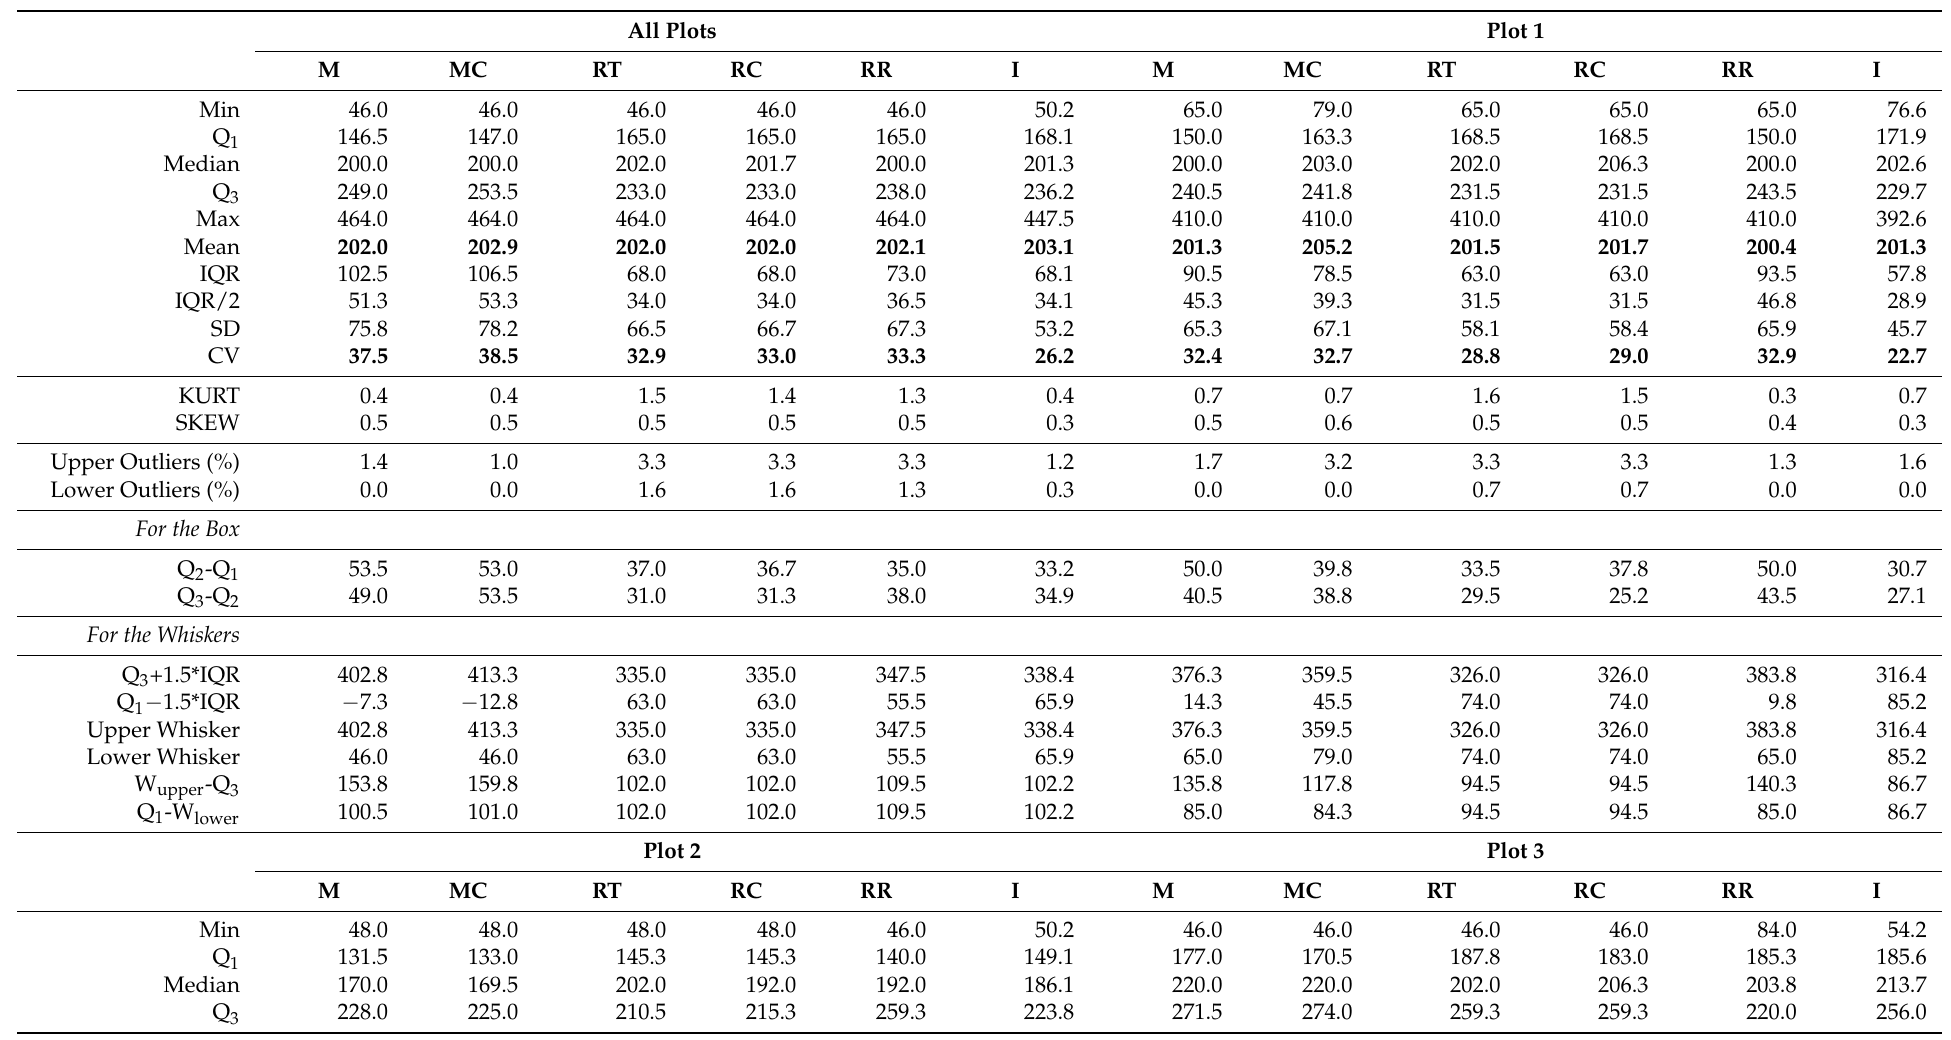
Table 2. Descriptive statistics for dry weight (DW)